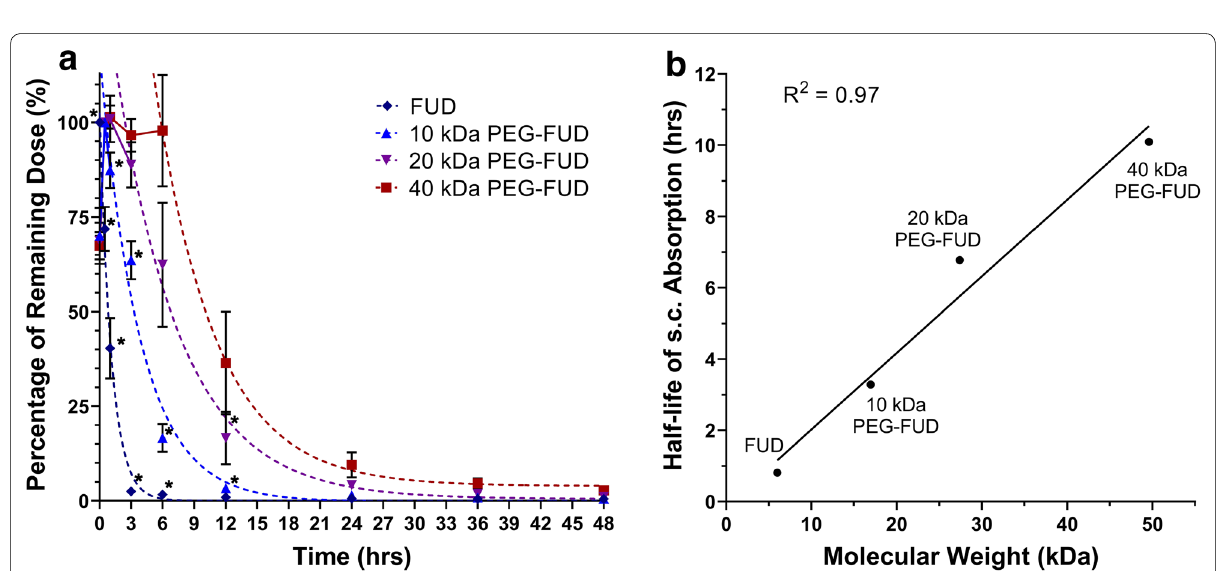
Fig. 8 a Percentage of drug dose (F SC %) remaining at the site of s.c. injection over time after administration of a FUD or 10 kDa, 20 kDa, or 40 kDa PEG-FUD and a sulfo-Cy5 conjugate dose between the shoulder blades of a mouse. A one phase decay function was applied to the terminal phase of the absorption to calculate F SC % 50% (t 1/2 ) values. Significance (p 0.05) of difference between mean F SC % values of a peptide and its larger = ≤ counterpart is denoted with an asterisk (*). n 3 b Relationship between apparent half-life (t 1/2 ) of peptide absorption and the peptide’s MW. Linear = regression analysis resulted in an r 2 correlation coefficient of